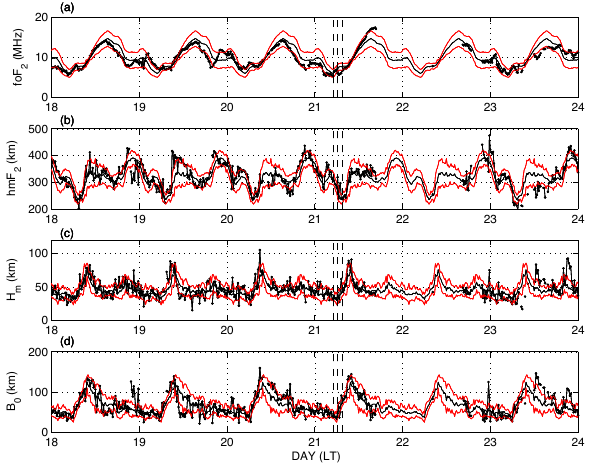
Figure 2. 3 Fig. 2. Variations in (a) fo F 2 , (b) hm F 2 , (c) H m , and (d) B 0 param- eters from 18 to 23 May 2012. The dotted, solid, and red solid lines denote the observed, monthly mean, and error bar values, respec- tively. The vertical dashed lines show the onset, second contact, and end time of the annular solar eclipse over Taiwan.